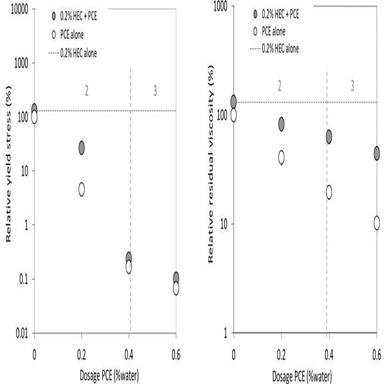
Relative yield stress (i.e., ratio between yield stress of the paste with polymer and yield stress of the reference paste) as a function of PCE dosage (left). Relative residual viscosity (i.e., ratio between the residual viscosity at the plateau of the paste with polymer and the residual viscosity of the reference paste) as a function of PCE dosage (right).